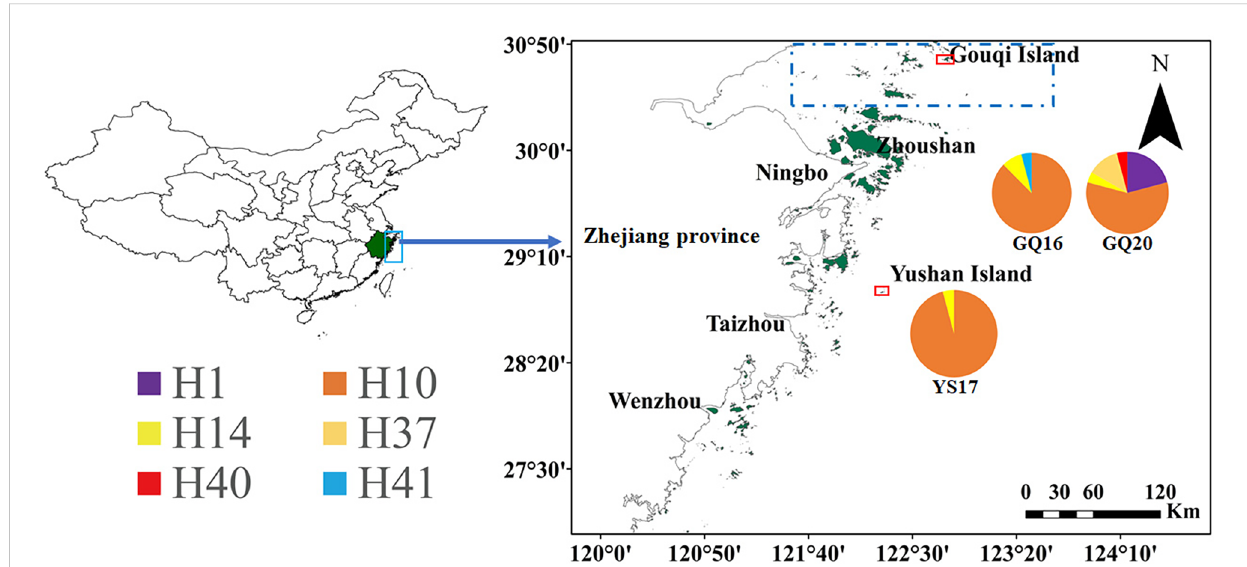
FIGURE 1 Geographic locations of Gouqi and Yushan Islands (indicated by red rectangle) in Zhejiang province, China, and the haplotypes of the combined cox3 and tatC – tLeu sequences in two temporal populations of Undaria pinnati fi da from Gouqi Island (GQ16 and GQ20) and one population from Yushan Island (YS17). The color areas in the pie charts are proportional to the haplotype frequency. Dashed rectangle indicates the rough range of Shengsi